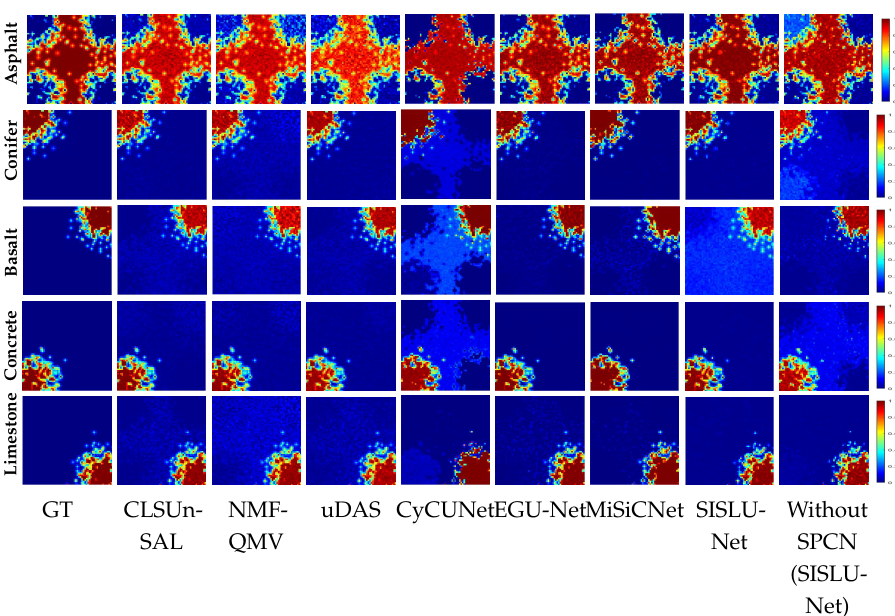
Figure 7. Estimated abundances by all competing methods on the Synthetic